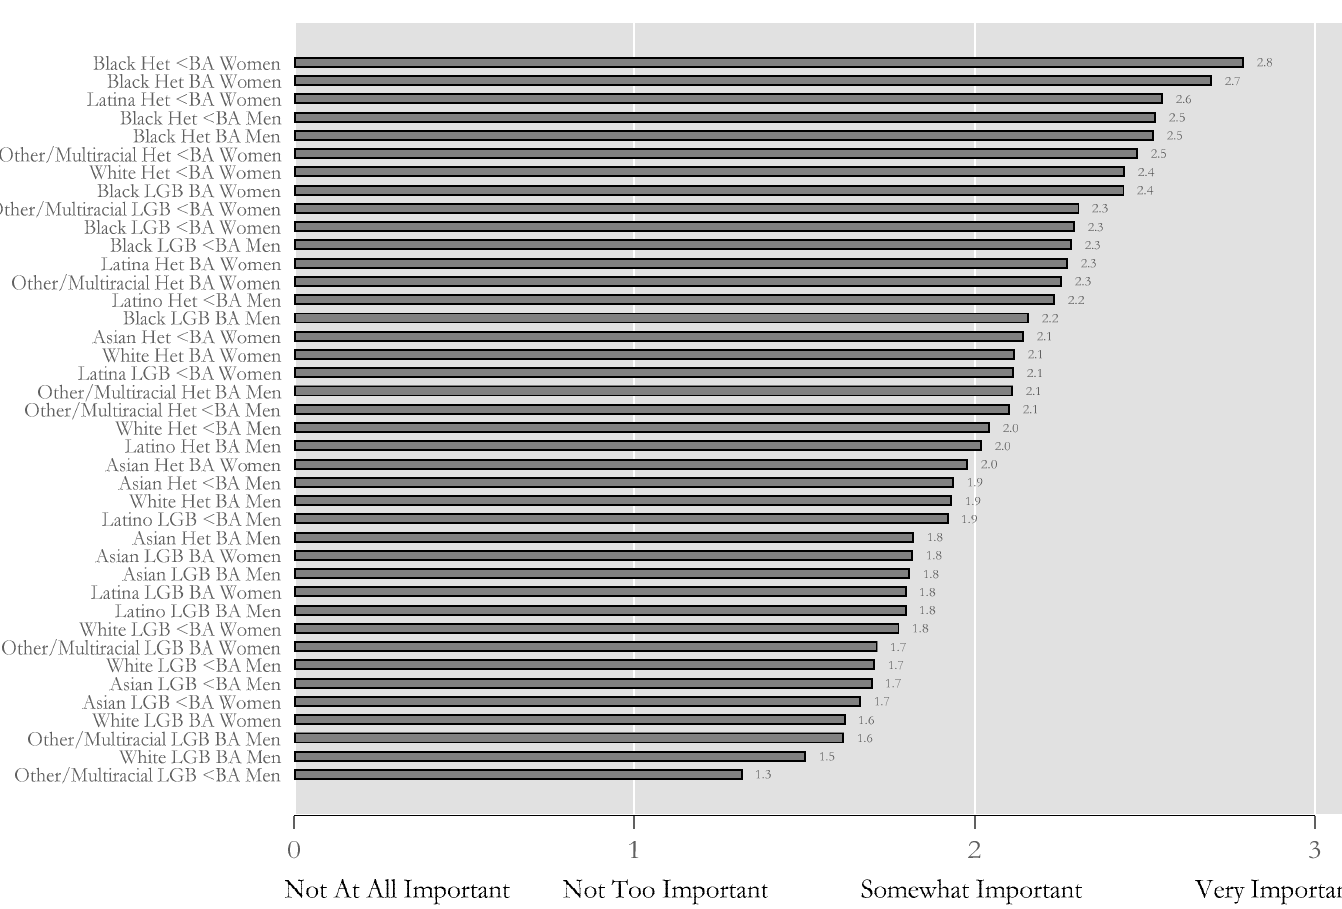
Figure 1. Religious salience across configurations of status characteristics, Religious Landscape Study (RLS) (N = 33,259).